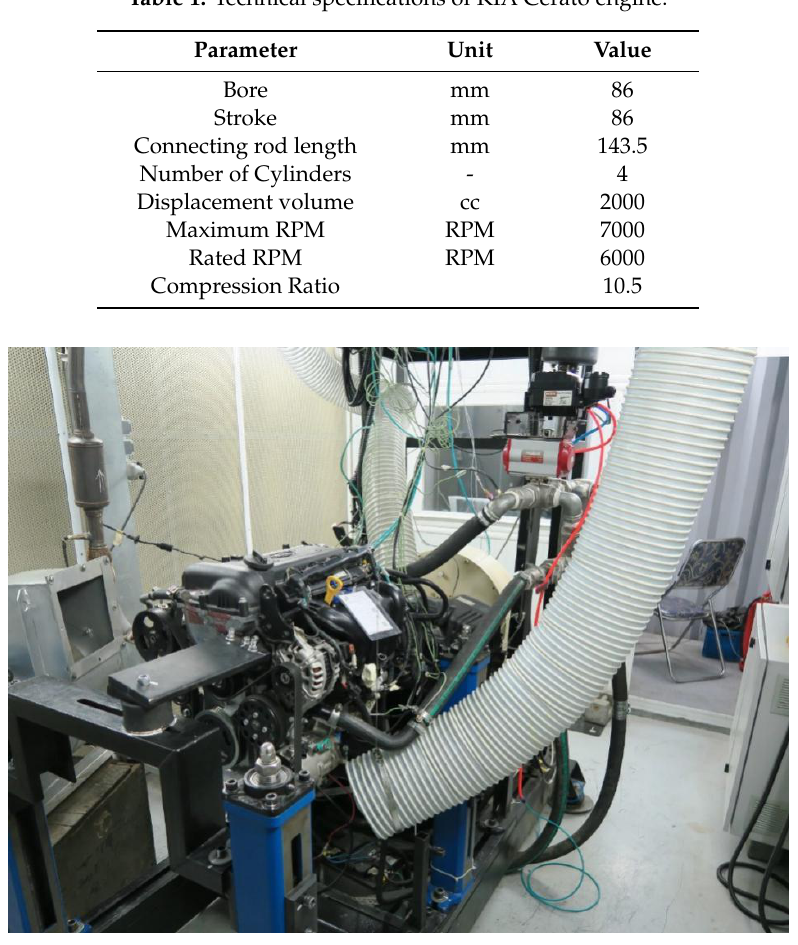
Figure 1. Experimental testing of KIA Cerato engine on engine test bed.